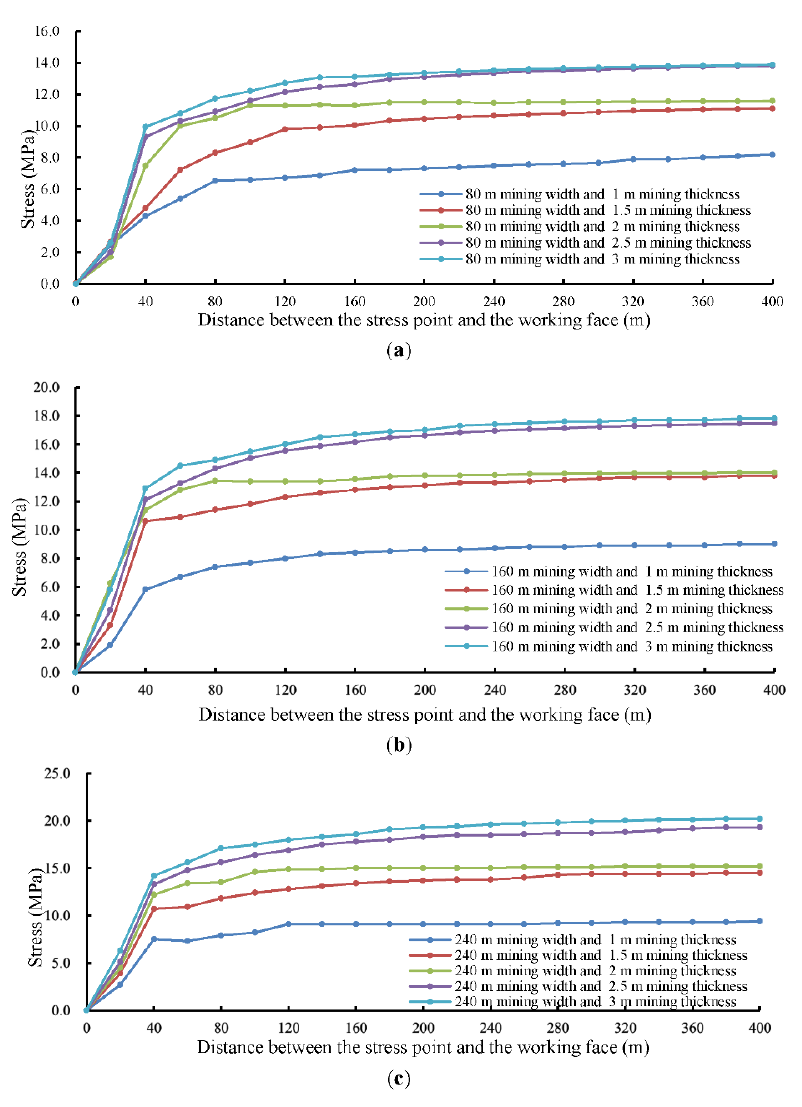
Figure 3. Stress profile of the backfilled pier-column with a constant mining width and variable mining thickness: ( a ) 80 m width; ( b ) 160 m width; ( c ) 240 m width.